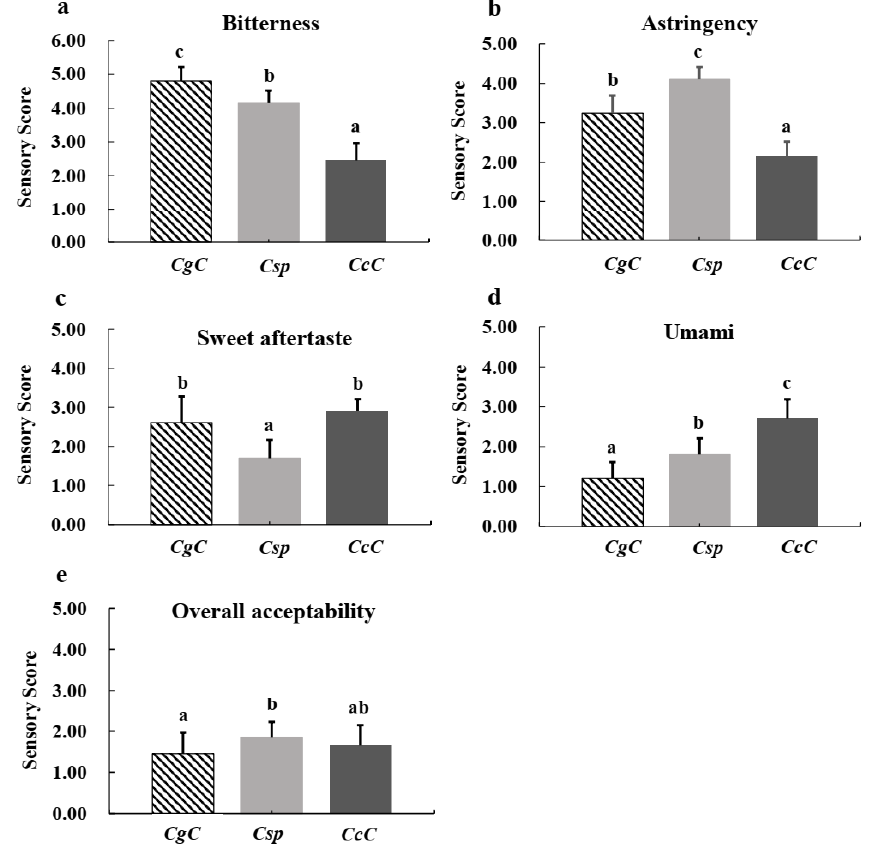
Figure 4. Sensory evaluation results of green tea infusions from three Camellia species. ( a ) Sensory scores of bitterness of green tea infusions from three Camellia species; ( b ) sensory scores of astringency of green tea infusions from three Camellia species; ( c ) sensory scores of sweet aftertaste of green tea infusions from three Camellia species; ( d ) sensory scores of umami of green tea infusions from three Camellia species; ( e ) sensory scores of overall acceptability of green tea infusions from three Camellia species. CgC —C. gymnogyna Chang ; Csp — C. sinensis var. pubilimba Chang ; CcC — C. crassicolumna Chang ; Values are mean ± SD ( n = 20). Different lowercase letters mean significant differences at p < 0.05 (Tukey’s HSD).